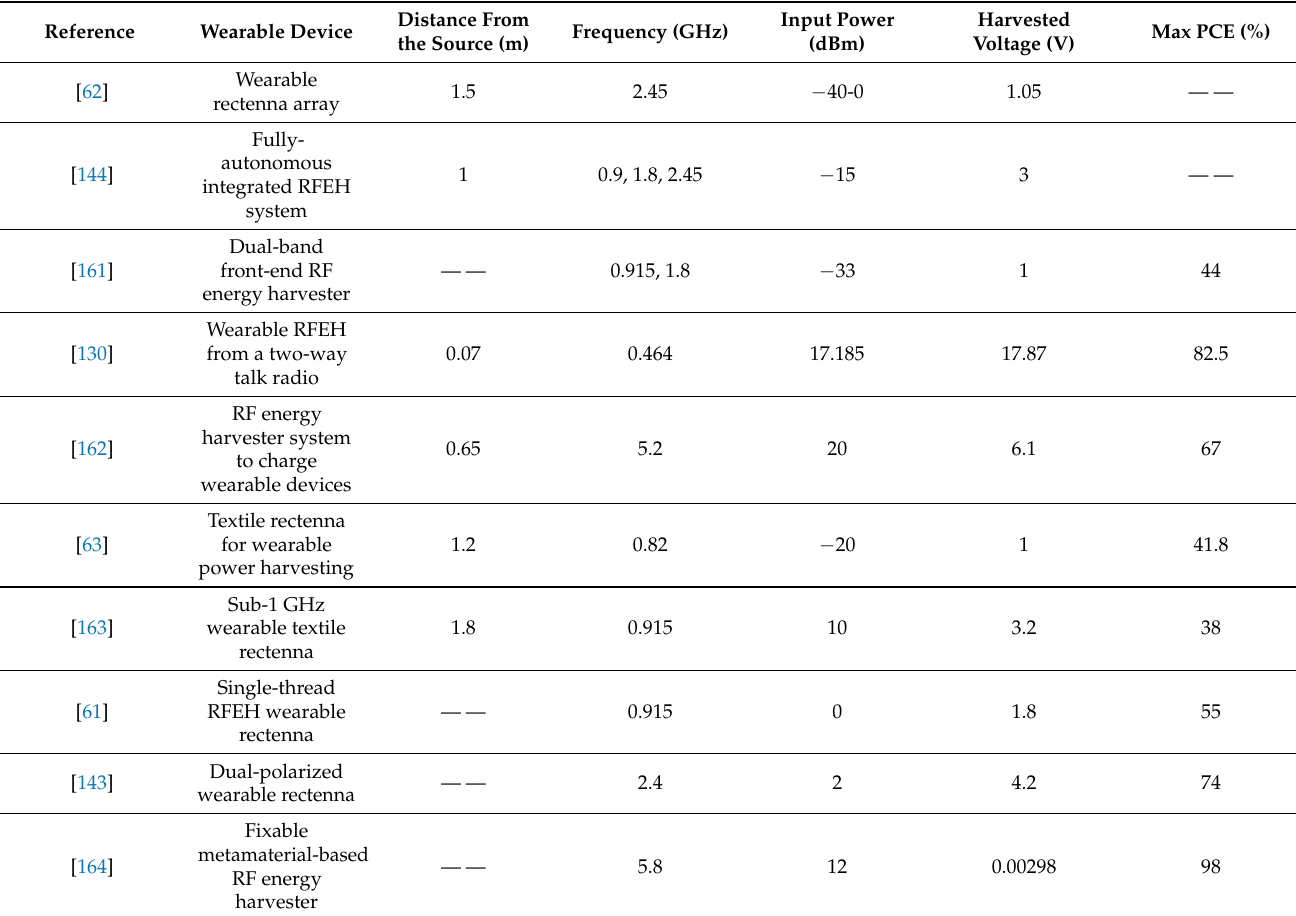
Table 5. Comparison of wearable RF energy harvester